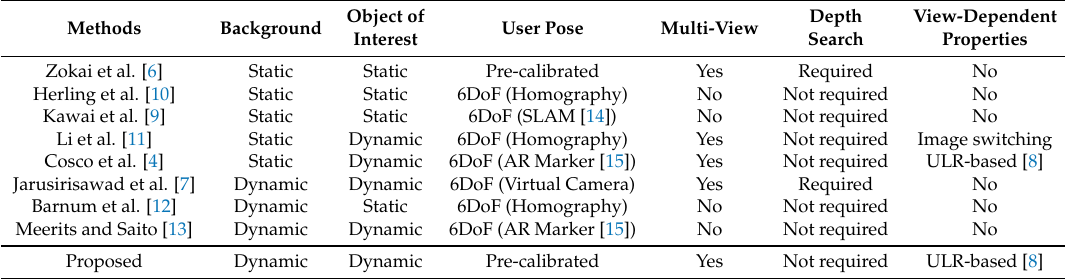
Table 1. Characteristics of existing DR methods compared to the proposed